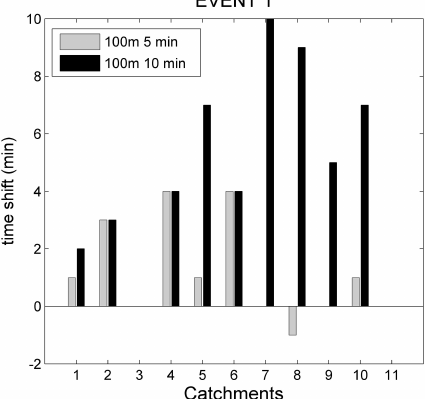
Figure 14. Time shift between maximum water depths of reference case (100m spatial resolution, 1min temporal resolution), and 5 and 10min simulation, at the outlets of the 10 subcatchments and of the whole catchment (no. 11).